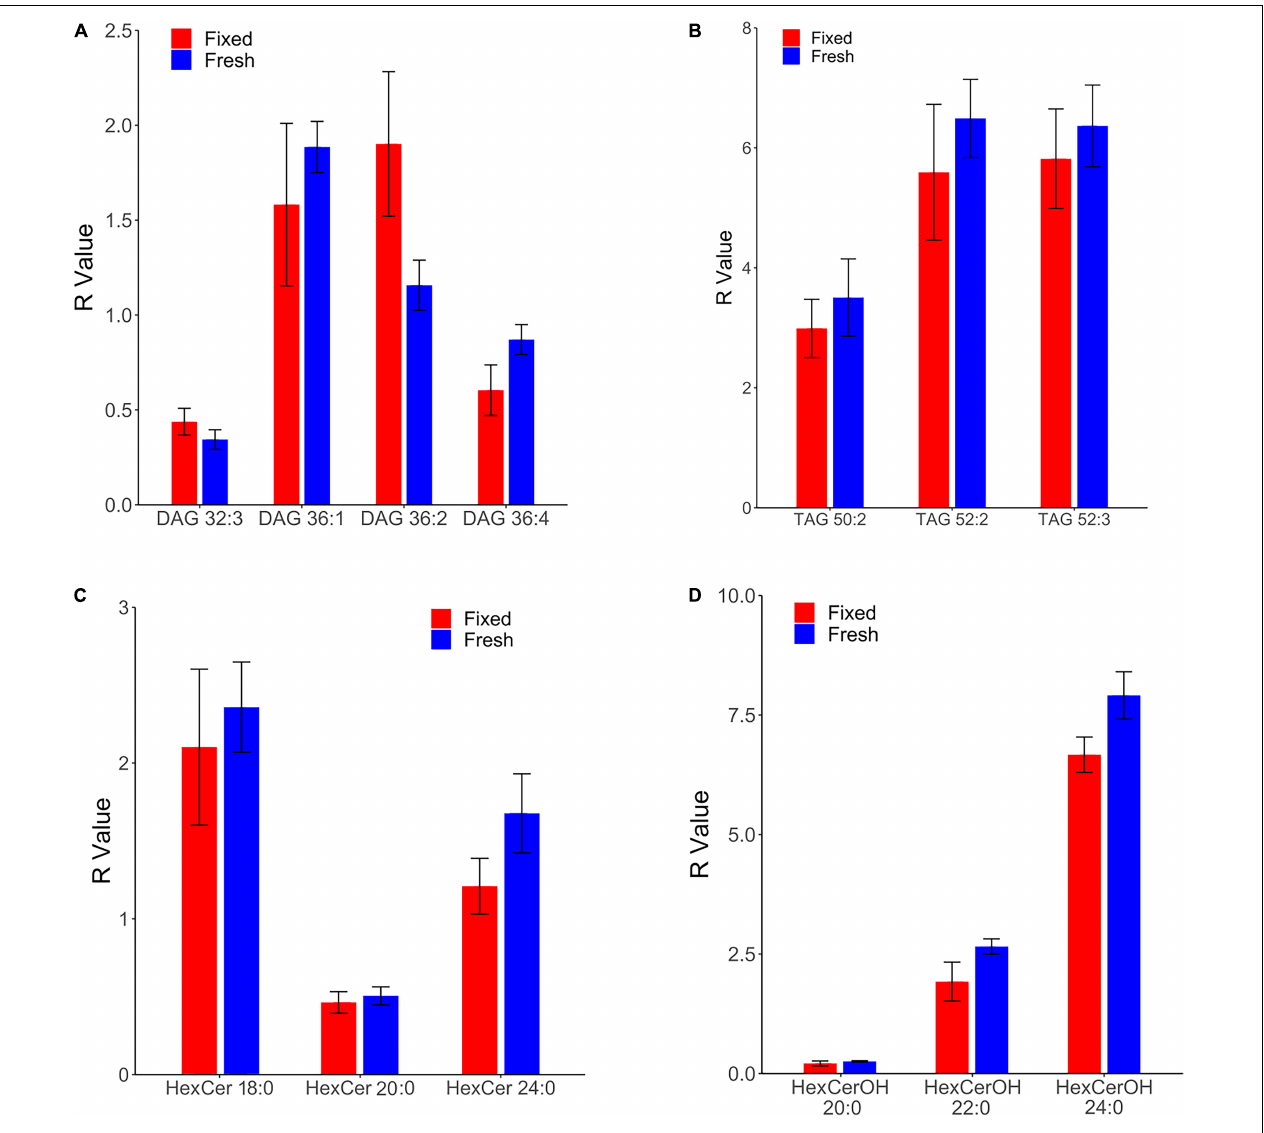
FIGURE 1 | Comparison of lipid concentrations in fresh and fixed samples of human frontal cortical gray matter reveals commensurate levels of four lipid families. R values of fresh and fixed samples were found to differ insignificantly using two-sample t -tests ( p > 0.05). Relative levels were calculated as a ratio of the peak area of the endogenous lipid to the peak area of the assigned internal standard, and were subsequently corrected for the wet weight of the sample to obtain the R value (relative level*(10/wet weight[mg])). (A) Four species of diacylglycerol (DAG) were found in commensurate levels in fresh and fixed brain tissue. (B) Three species of triacylglycerol (TAG) were found in commensurate levels in fresh and fixed brain tissue. (C) Three species of hexosyl ceramide (HexCer) were found in commensurate levels in fresh and fixed brain tissue. (D) Three species of hydroxy hexosyl ceramide (HexCerOH) were found in commensurate levels in fresh and fixed brain